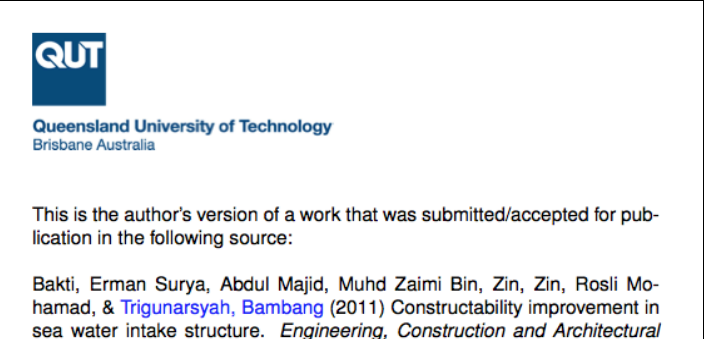
Figure 1 An example of how a green copy should ideally be posted, in this case in an institutional